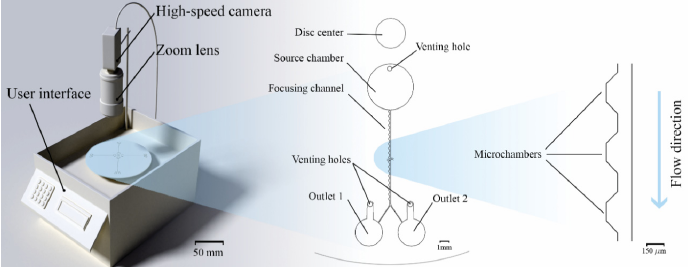
Figure 1. Three-dimensional (3D) illustration of the spinning system with all its components, and the microfluidic design of the focusing channel. Microchambers are implemented along one side of the focusing channel to enhance particle focusing.